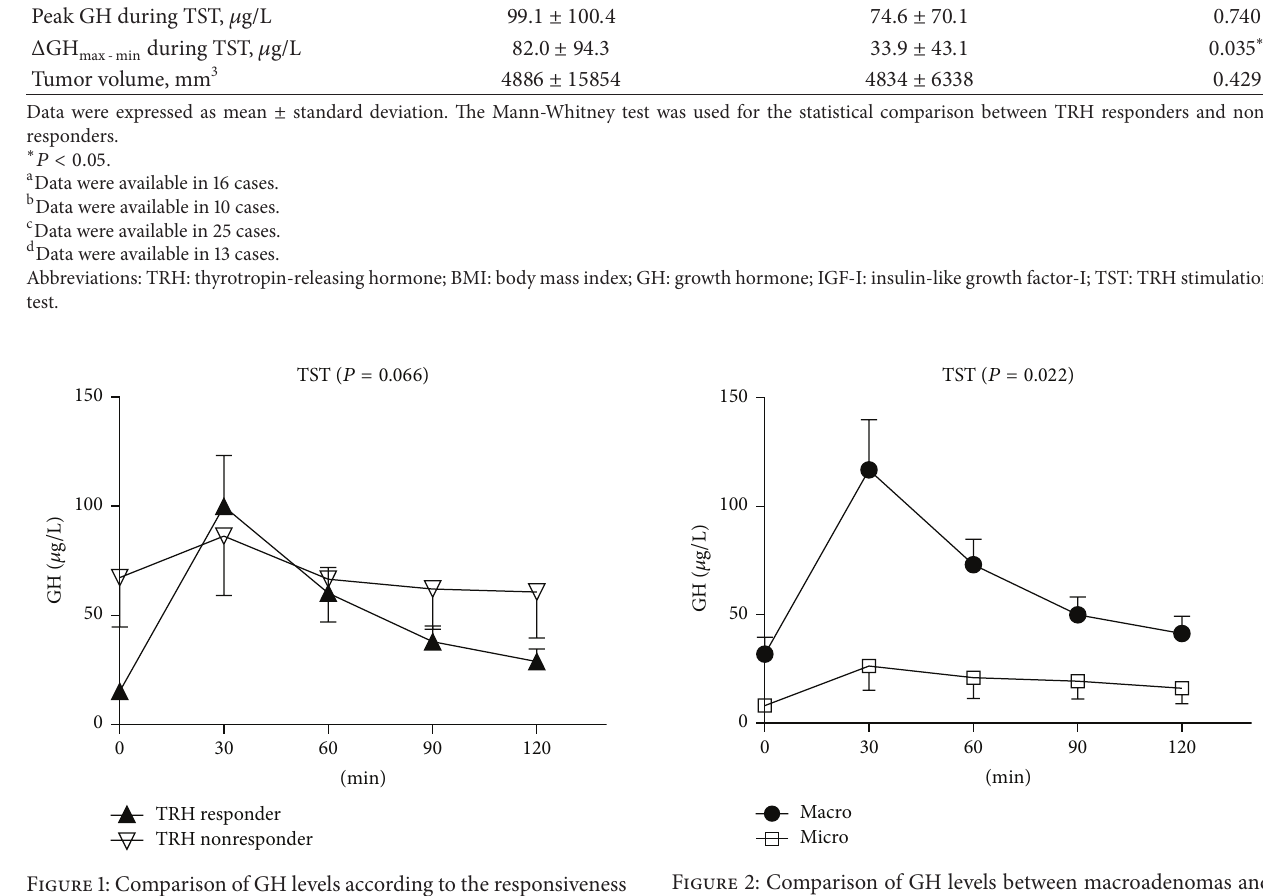
Figure 1: Comparison of GH levels according to the responsiveness to TRH during the entire TST time. Data represent mean ± standard error. RMANOVA was used for the statistical comparison, and Greenhouse-Geisser correction was applied if compound symmetry was not satisfied based upon Mauchly’s sphericity test. Abbrevia- tions: GH: growth hormone; TRH: thyrotropin releasing hormone; TST: TRH stimulation test; RMANOVA: repeated measure one-way analysis of variance.